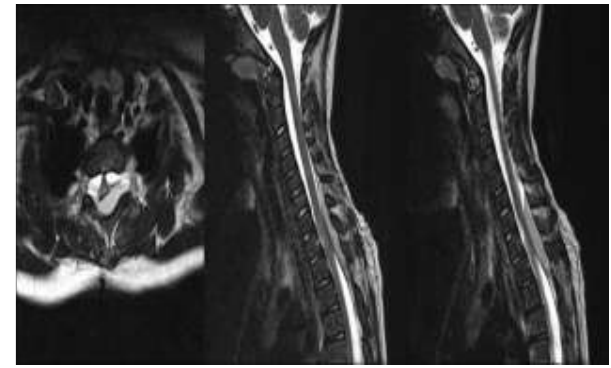
Figure 1. Axial and sagittal MRI images showing spinal cord epidural hematoma